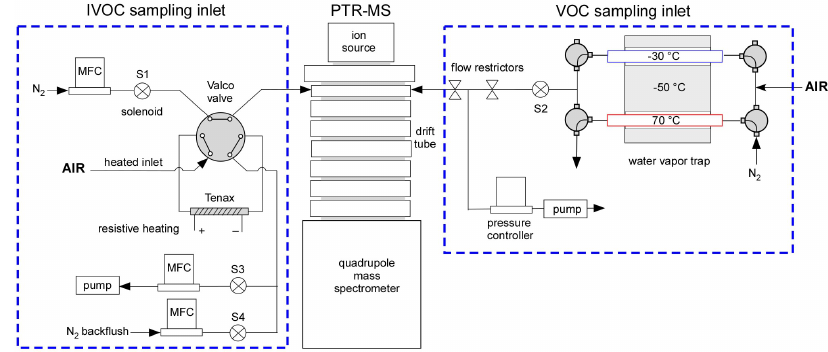
Fig. 1. Plumbing schematic showing thermal desorption sampler for IVOC compounds and VOC sampling system with water vapor